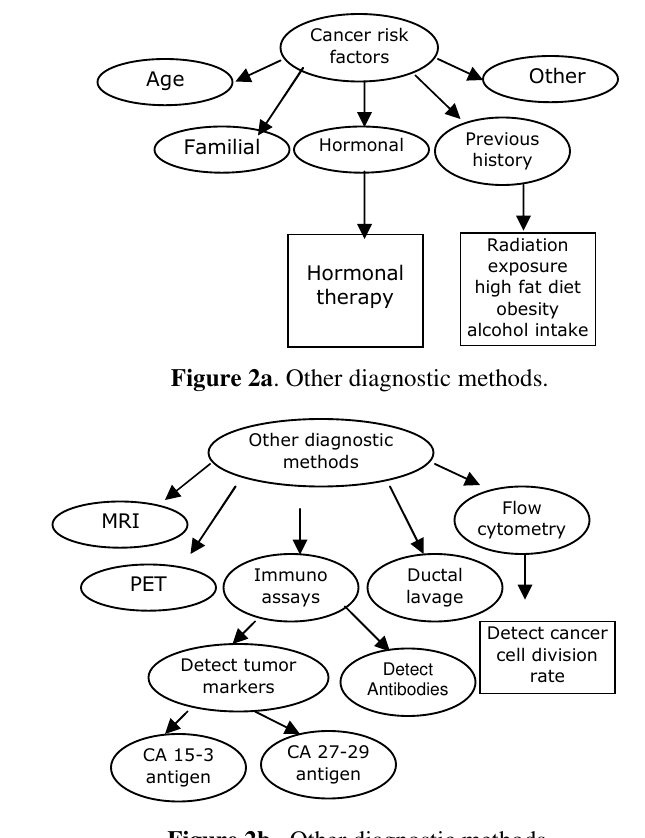
Figure 2b . Other diagnostic methods.